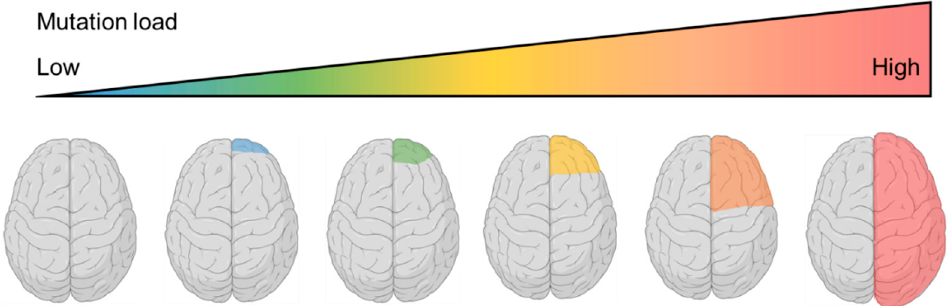
Figure 3. Focal cortical dysplasia (FCD) and hemimegalencephaly (HME) as a continuum of cortical dysplasias caused by commonly shared genetic variants with different mutation load. In small FCD, a small subset of cells is affected, which contribute to the small mutation load and restricted lesion. In HME, a larger number of cells carry the somatic variant, resulting in higher mutation load and a more diffuse lesion. It is important to acknowledge that there are even smaller lesions including presumed MRI ‐ negative lesions within this spectrum, associated with ultra ‐ low mutation load.